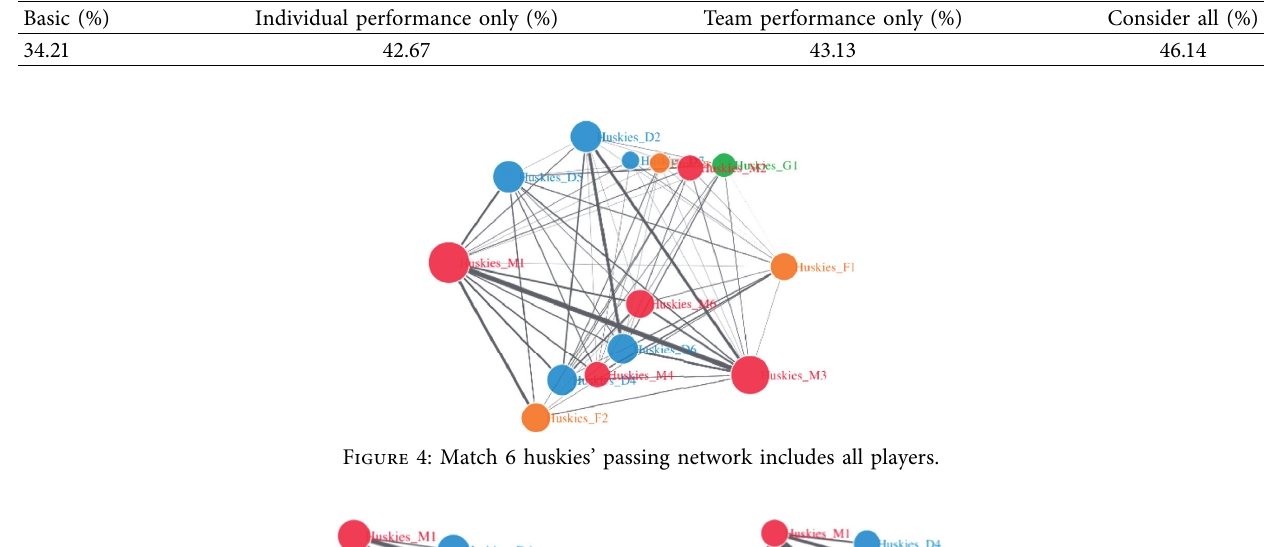
Table 2: Comparison of the win rate of different optimizations in the passing network.